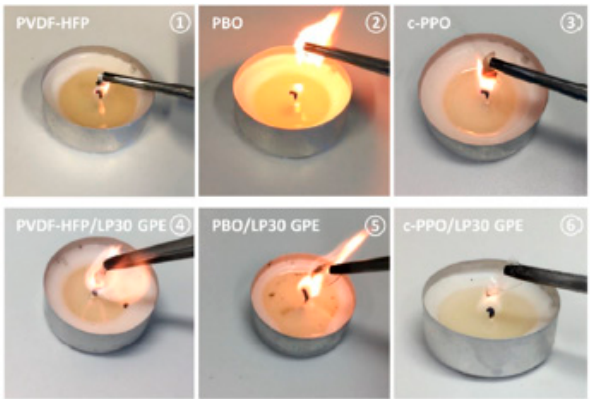
Figure 17. Flammability measurement of PVDF-HFP (polyvinylidenefluoride-hex- afluoropropylene), PBO (poly [benzyl methacrylate-co-oligo(ethylene glycol)ether methacrylate]), and c-PPO (cross-linked poly[dimethyl-p-vinyl benzyl phosphonate-co-oligo (ethylene glycol) meth acrylate] co-polymer) polymer matrices and their corresponding GPEs. The addition of 0.5% of diethyl(thiophen-2-ylmethyl) phosphonate (DTYP) additive to the base electrolyte aided in improving the capacity retention of a high-voltage Li-ion cell using LiNi 0.5 Mn 1.5 O 4 from 18% to 85% after 280 cycles at 1C at 60 °C. The novel electrolyte also aided in reducing the self- extinguishing time of the electrolyte from 88 s to 77 s [58]. Figure 18 shows the flammability tests and the cycling performance of the batteries with and without DTYP electrolyte.